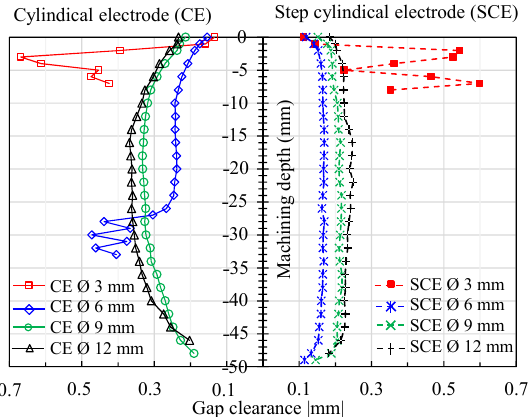
Figure 8. Gap clearance of the drilled hole with electrodes of various diameters.